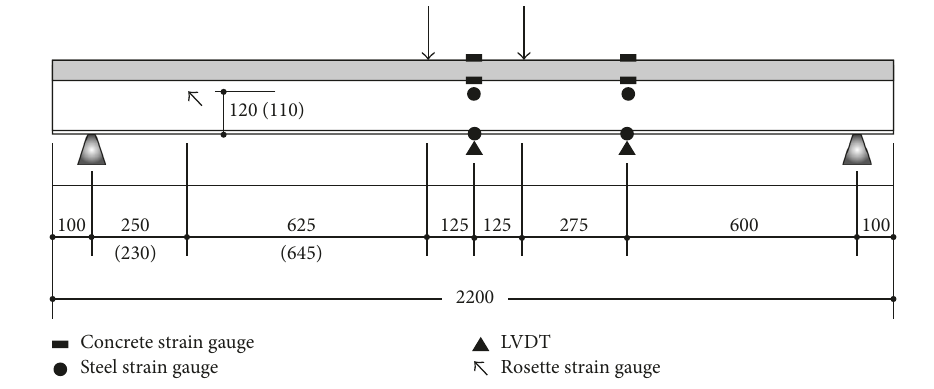
Figure 4: Loading test setup and sensor layout Table 3: Crack and failure patterns of test members.